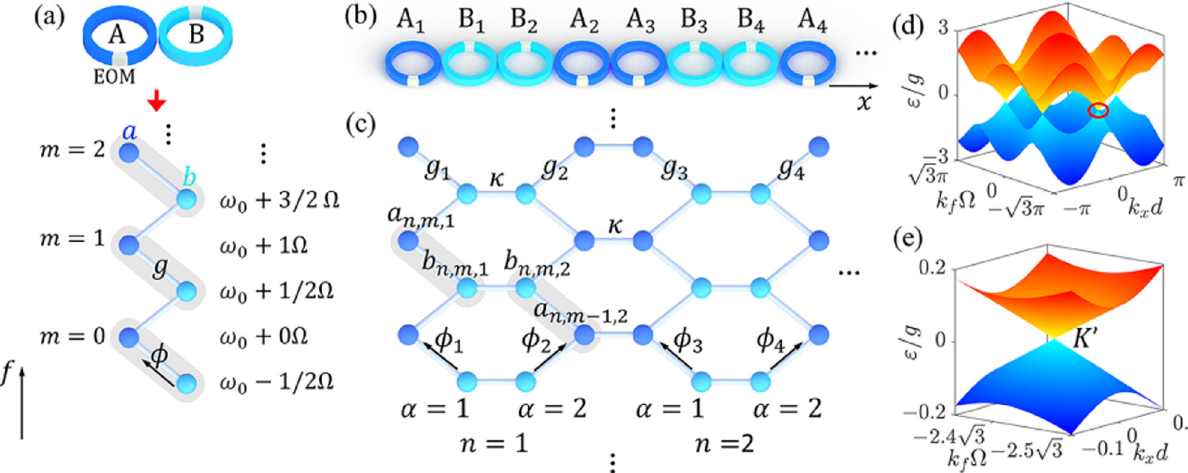
Fig. 1 Construction of synthetic honeycomb lattice. a Rings A and B support a set of resonant modes a (blue circle) and b (cyan circle) separated by the free spectral range Ω in the frequency dimension ( f ). Both rings are modulated by electro-optic modulator (EOM) with modulation phase ϕ , modulation frequency Ω /2, and effective hopping amplitude g . ω 0 and ω 0 − Ω /2 are central resonant frequencies of ring A and ring B. m denotes the index of the m th resonant mode. b A one-dimensional array of ring resonators is composed of groups of pairs of rings in a along the spatial dimension x . A i (B i ) represents the i th ring A (ring B), where i is a positive integer. c The system in b can be mapped into a honeycomb lattice in a synthetic space including one spatial dimension ( x ) and one frequency dimension ( f ). a n , m , α and b n , m , α represent the operator for the fi eld at the m th mode in ring A and ring B, which are labeled by integers n and α as indicated in the fi gure. g i and ϕ i are the corresponding effective hopping amplitude and modulation phase, while κ is the coupling strength. d The band structure of the honeycomb lattice in the reciprocal space ( k x , k f ), where k x and k f are wave vectors reciprocal to spatial and frequency axes, ε is the eigenvalue (frequency shift of the fi eld), and d denotes the horizontal distance between two sites with same types in the synthetic lattice. e The zoomed-in Dirac cone at K 0 point in d